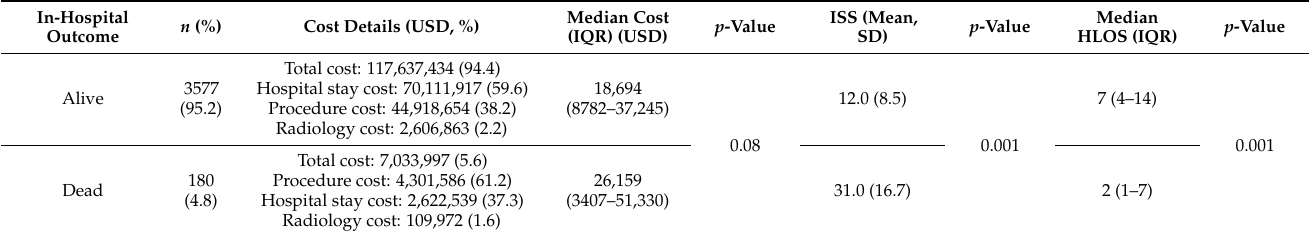
Table 2. Comparison of median costs incurred, injury severity and hospital length of stay by in- hospital outcomes in patients with WRIs ( n =